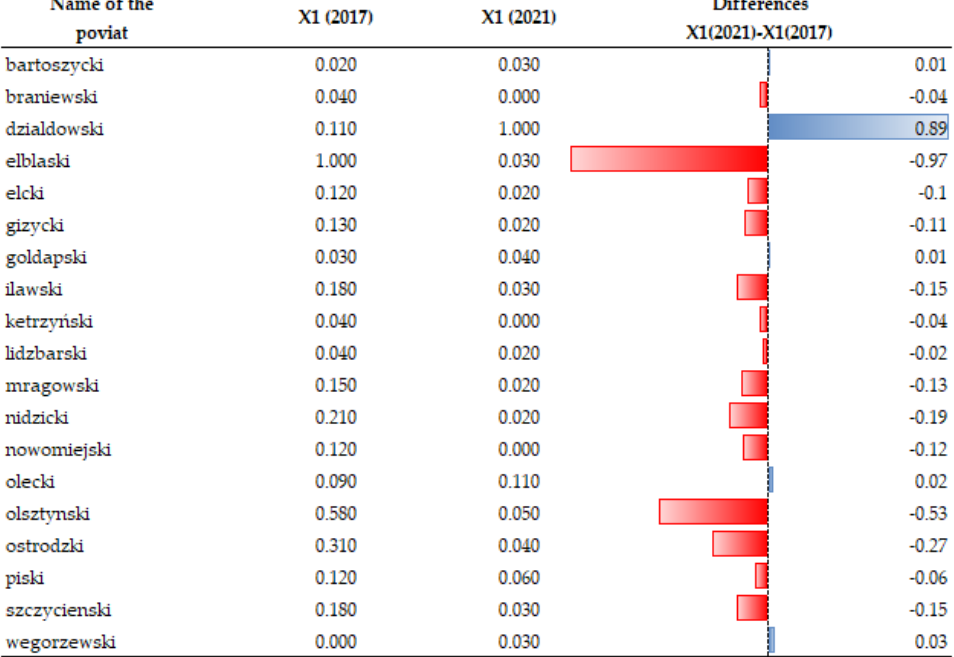
Figure 10. Changes in index of the financial loss (X1) caused by extreme weather phenomena and weather anomalies in individual spatial units. Source: own study on [108].